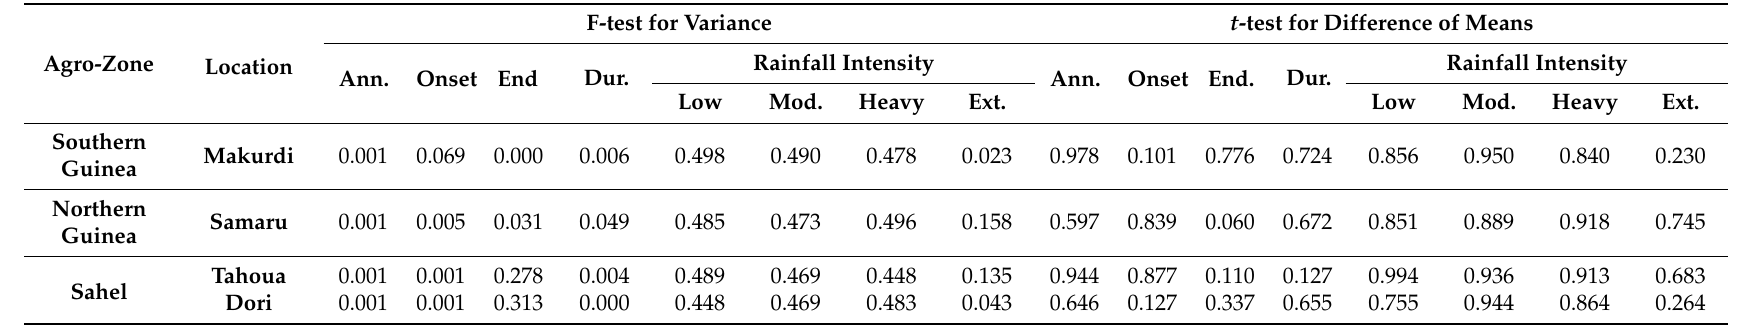
Table 2. Evaluation summary statistics for average annual rainfall, onset, cessation, duration and rainfall intensity of the growing season, 1976/1980–2005. F-test for Variance t -test for Difference of Means Agro-Zone Location Ann. Ann. Dur.